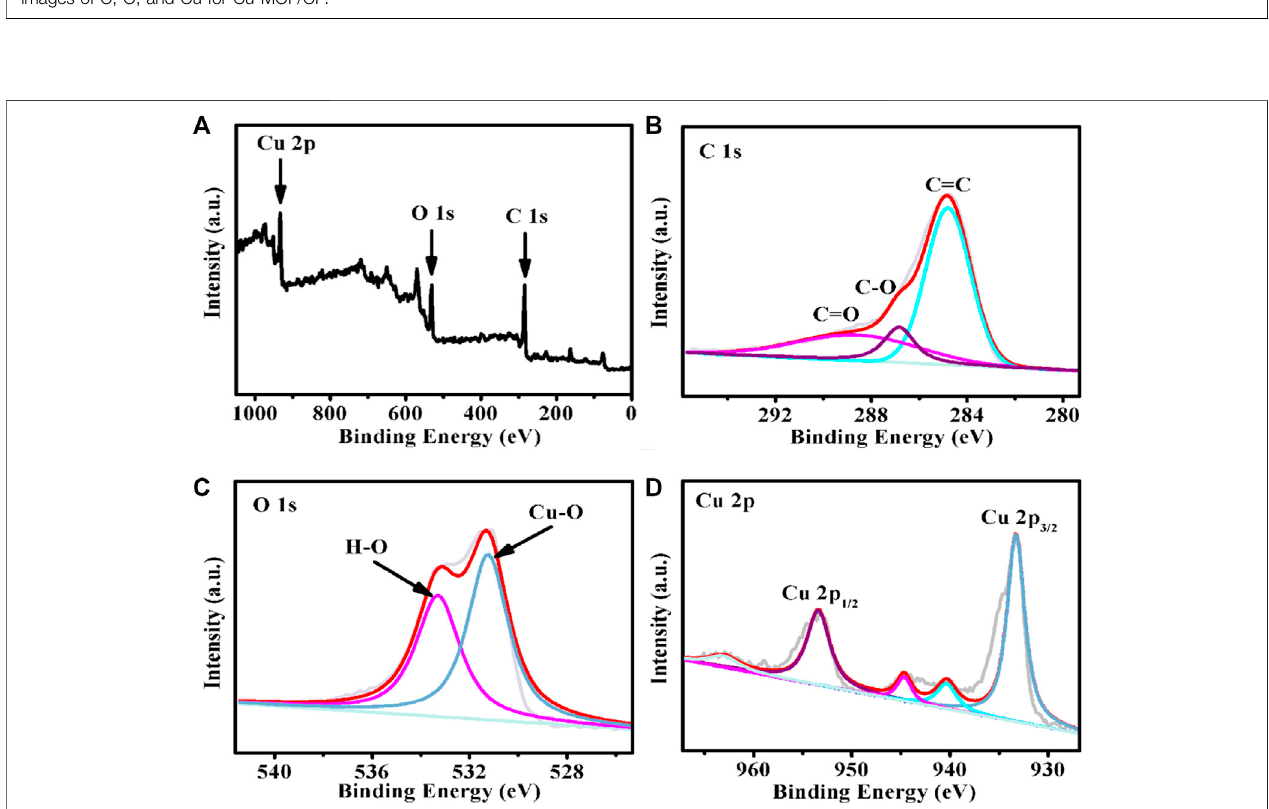
Frontiers in Chemistry |